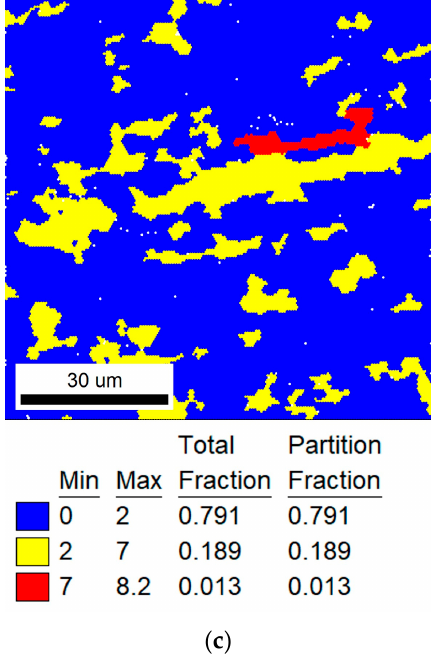
Figure 5. Grain orientation spread (GOS) of annealed Ti 50 Ni 47 Fe 3 alloys. ( a ) 400 °C/60 min/AC; ( b ) 500 °C/60 min/AC; and ( c ) 600 °C/60 min/AC.